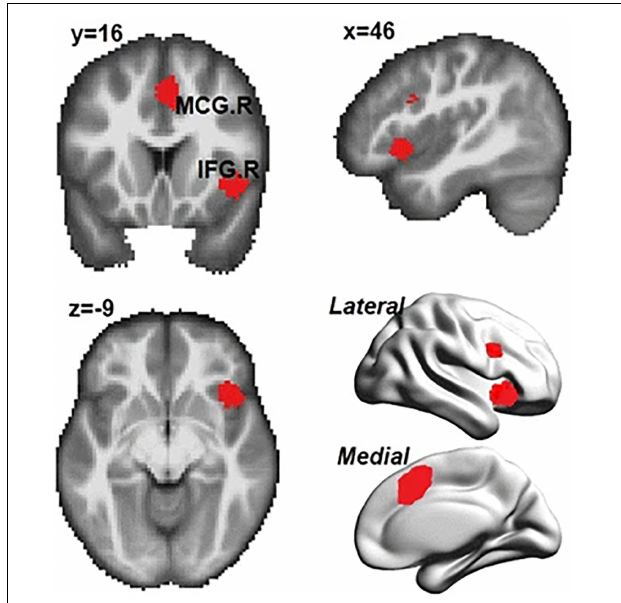
FIGURE 1 | Common regions activated in subprocesses of inhibition (i.e., interference resolution, action withholding, and action cancelation). IFG.R, right inferior frontal gyrus; MCG.R, right median cingulate and paracingulate gyri. Adopted from Zhang et al. (2017) under